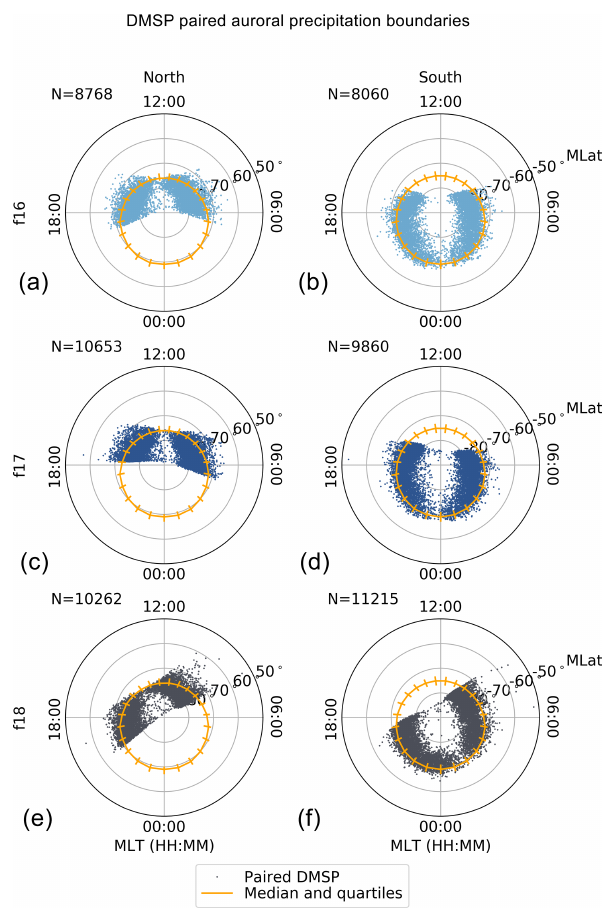
Figure 1. Paired AMPERE R1–R2 boundaries and DMSP SSJ OCBs for both hemispheres (Northern Hemisphere is shown in a , c , and e ; Southern Hemisphere is shown in, b , d , and f ) and each satel- lite. The scattered points show the DMSP SSJ OCBs, and the gold circle shows the median location of the AMPERE R1–R2 bound- aries. The scatter bars denote the quartiles of the paired AMPERE R1–R2 boundaries.